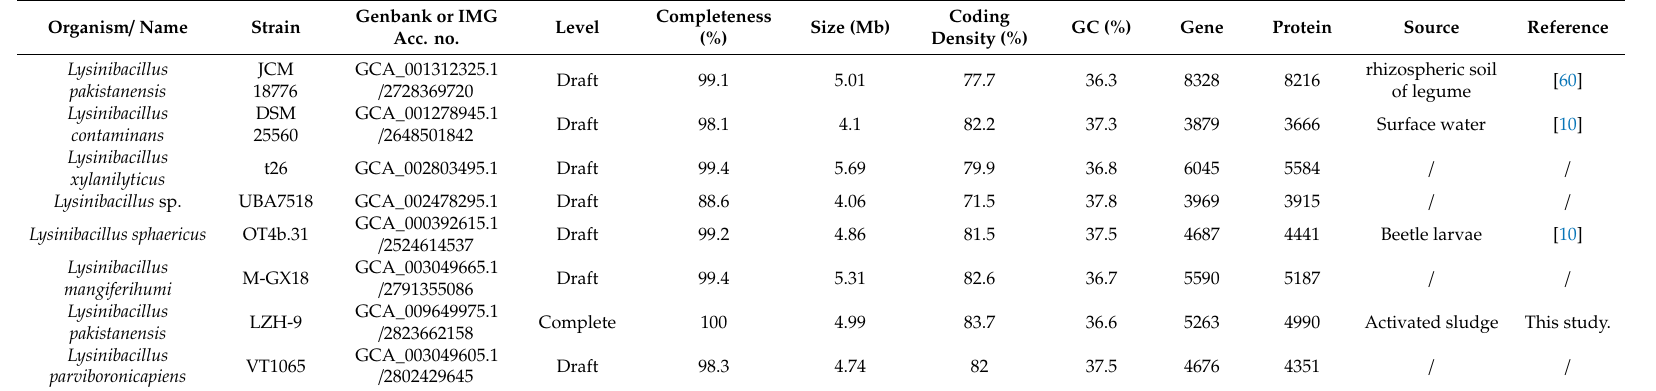
Table 2. For features of the eight Lysinibacillus genomes involved in this